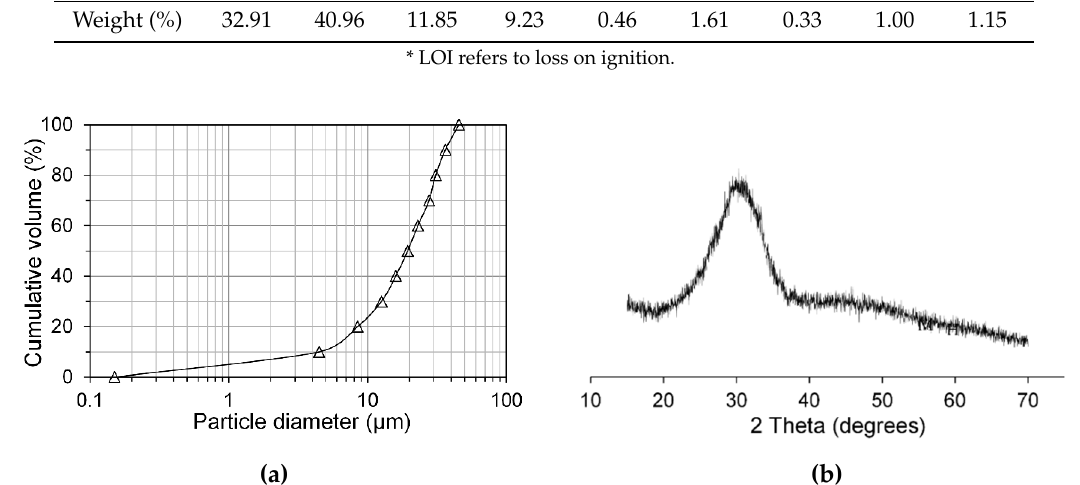
Figure 2. Particle size distribution ( a ) and X-ray diffraction pattern ( b ) of slag, determined by laser-diffraction and diffractometer, respectively.